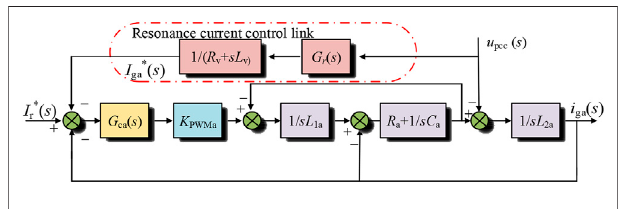
FIGURE 9 | Control block diagram of active impedance.